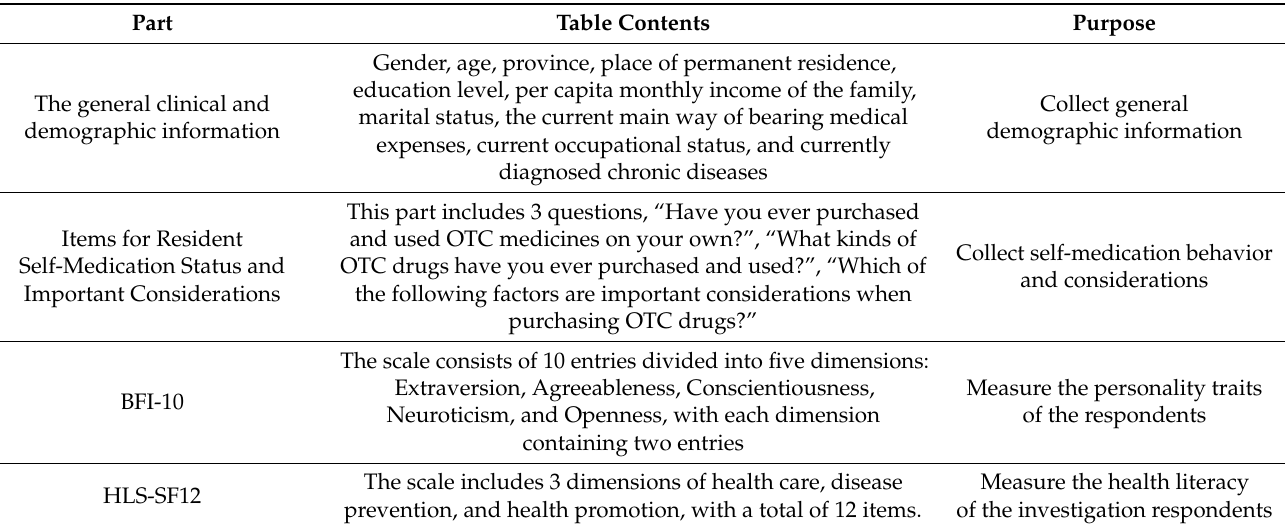
Table 1. Content and functions of the four parts of the